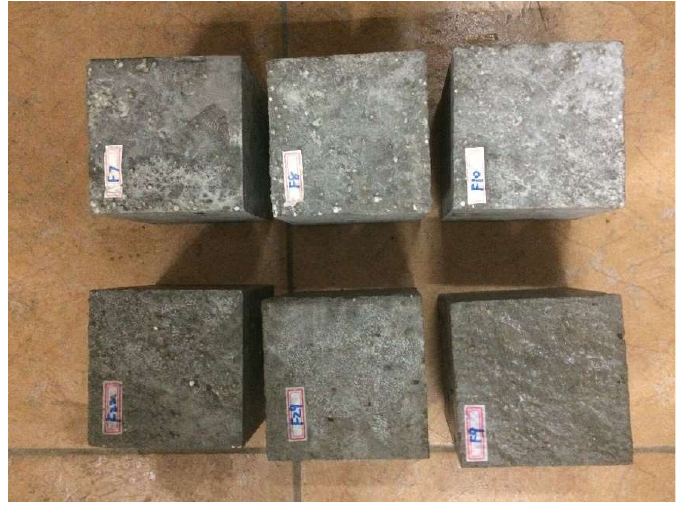
Figure 3. Specimens of group B and group C.